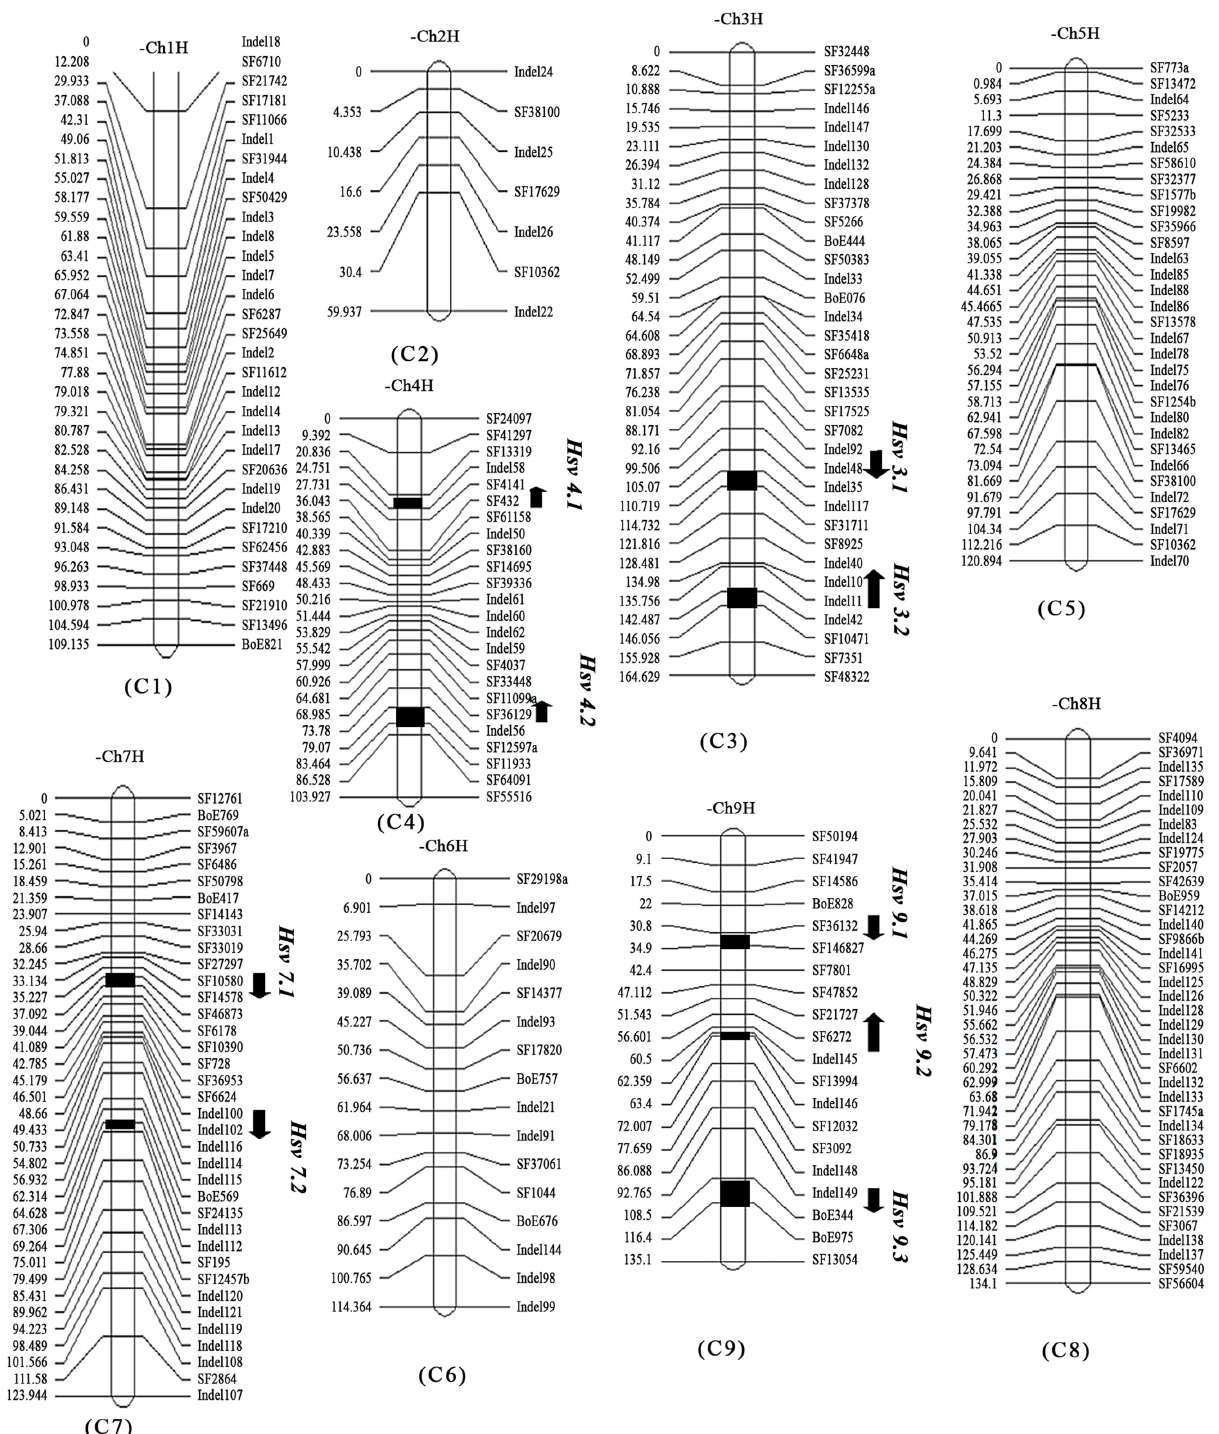
Fig 4. Genetic linkage map and positions of QTLs associated with heading splitting resistance in a cabbage DH population. Marker locations are listed to the right and recombination distances (cM) to the left of each linkage group. Locations of QTLs are indicated by names and arrows to the right of the linkage groups. Arrows indicate the relative effect of the 96 – 100 allele with upward for increasing and downward for decreasing.